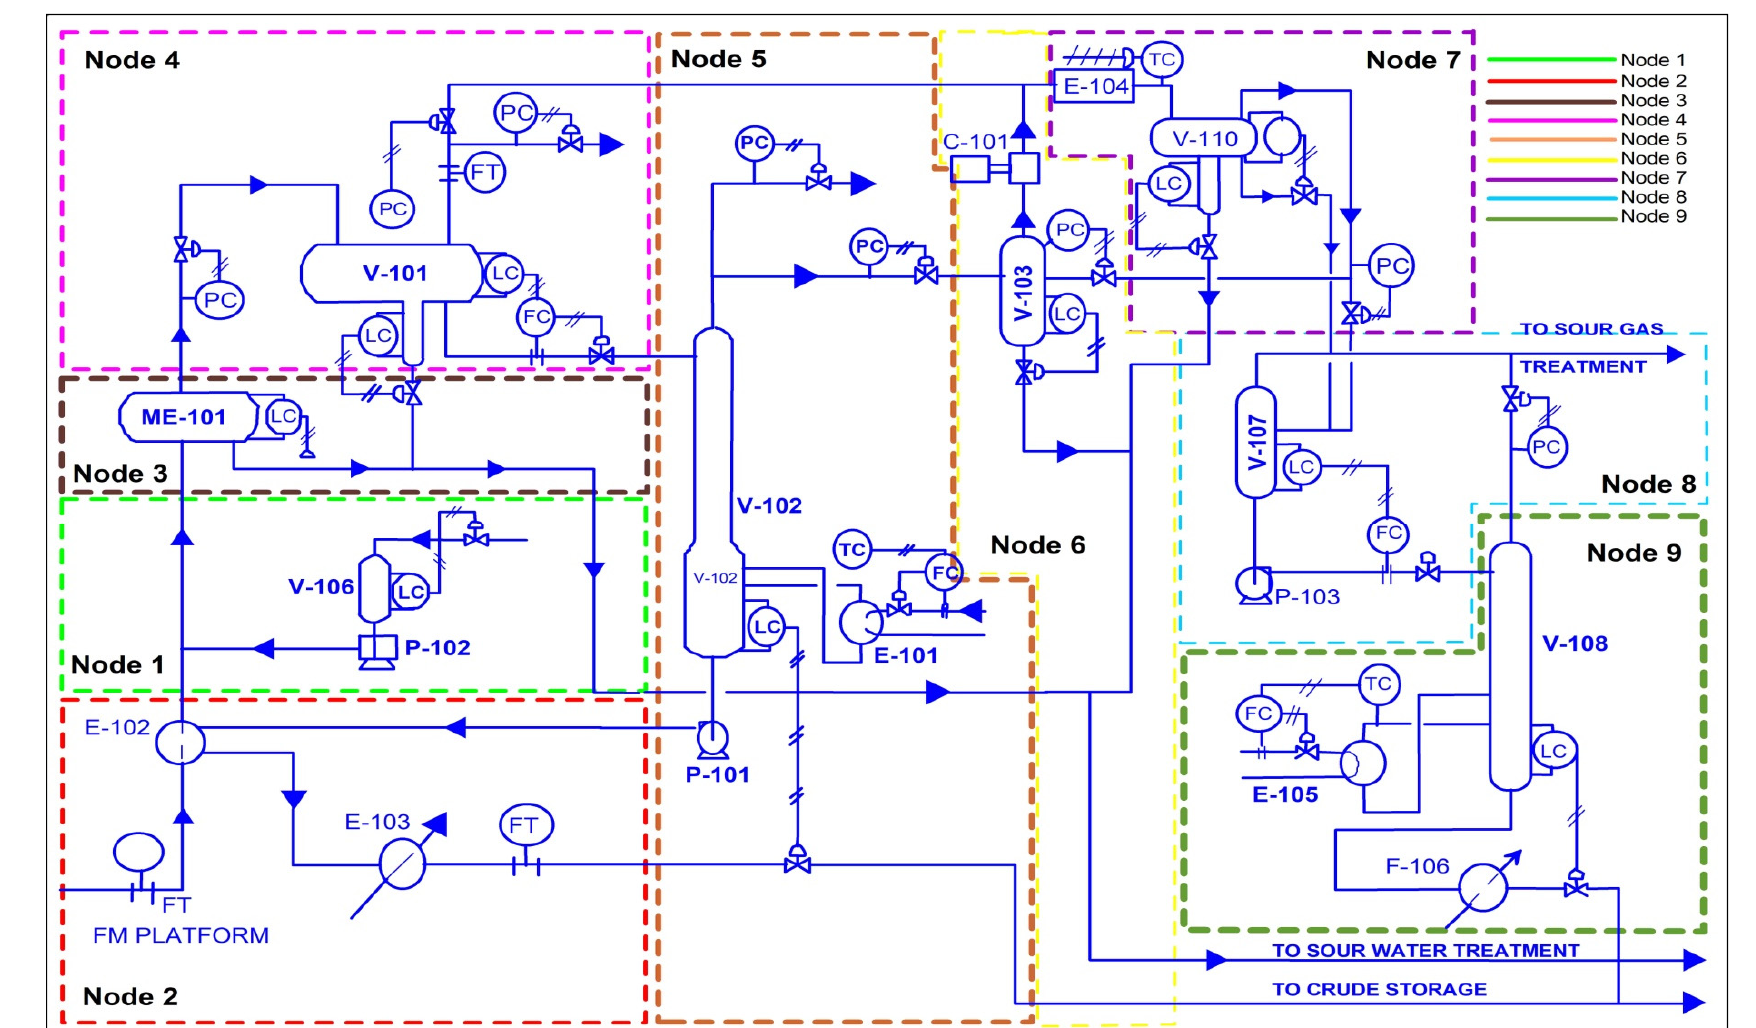
Figure 2. The process flow diagram of the SCOPI’s units .